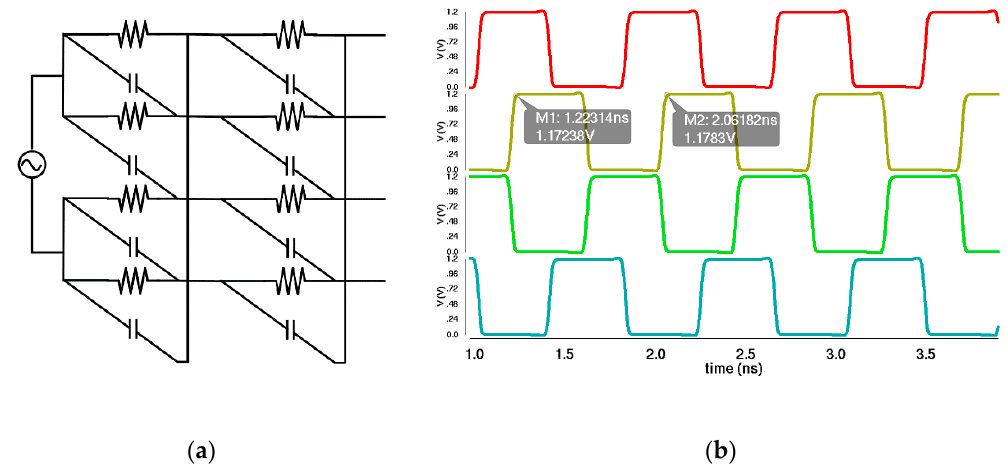
Figure 16. Two-stage polyphase filter in: ( a ) the proposed circuit; and ( b ) the quadrature LO generation.